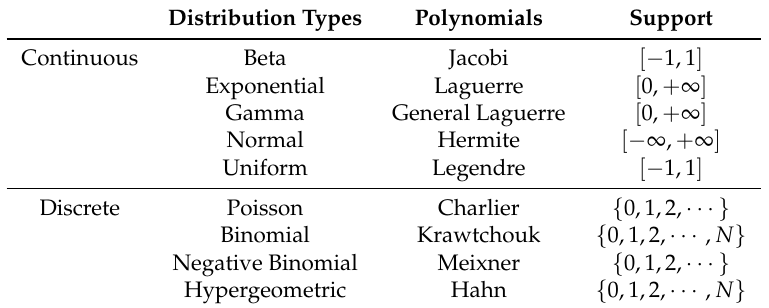
Table 1. Wiener–Askey polynomials and their corresponding random variables; N is a finite